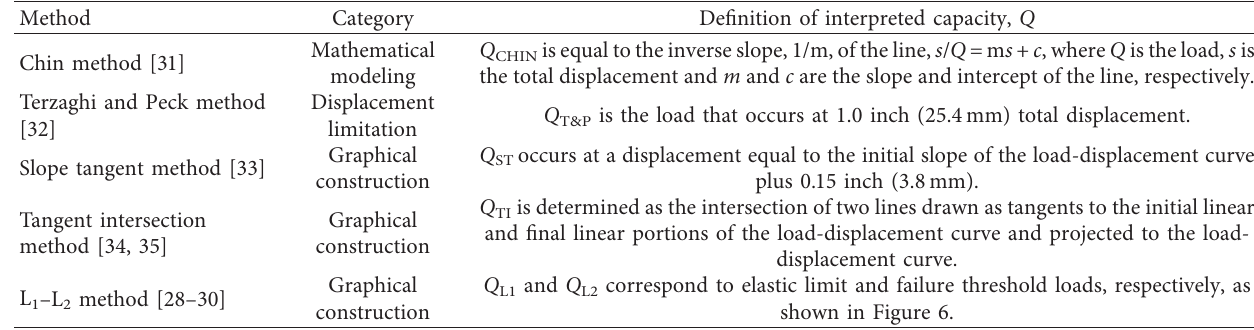
Table 2: Definitions of representative interpretation criteria examined in this study.